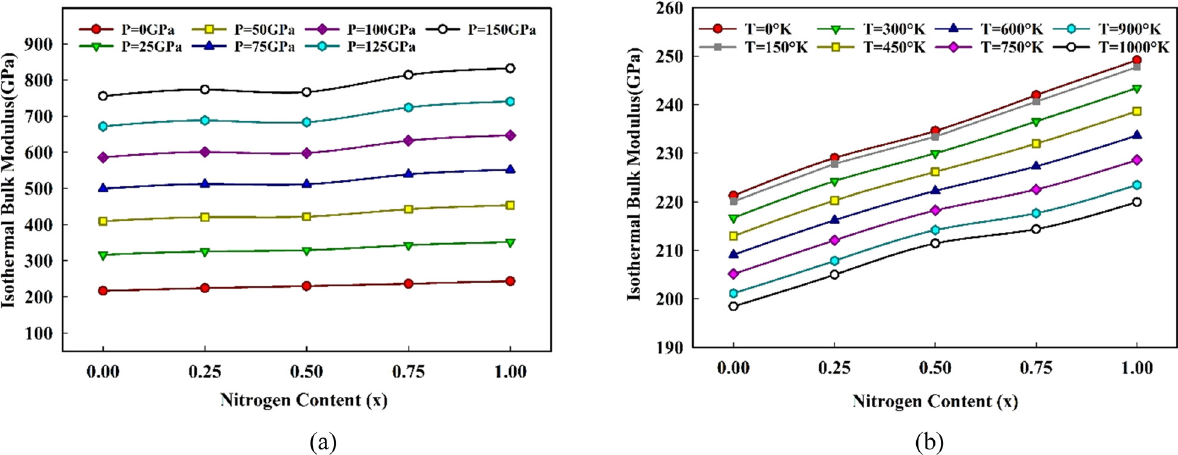
Figure 3: Isothermal bulk modulus of ZrC ( 1 − x ) N x as a function of nitrogen content ( x ) for ( a ) di ff erent pressures at 300 K and ( b ) di ff erent temperatures at zero